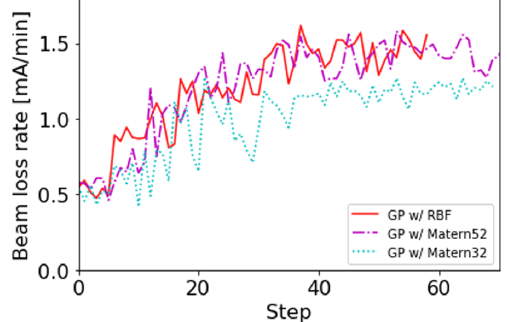
FIG. 3. Online machine optimization using RBF and Matern kernels for the archive data-informed Gaussian process with ML- II kernel learning.